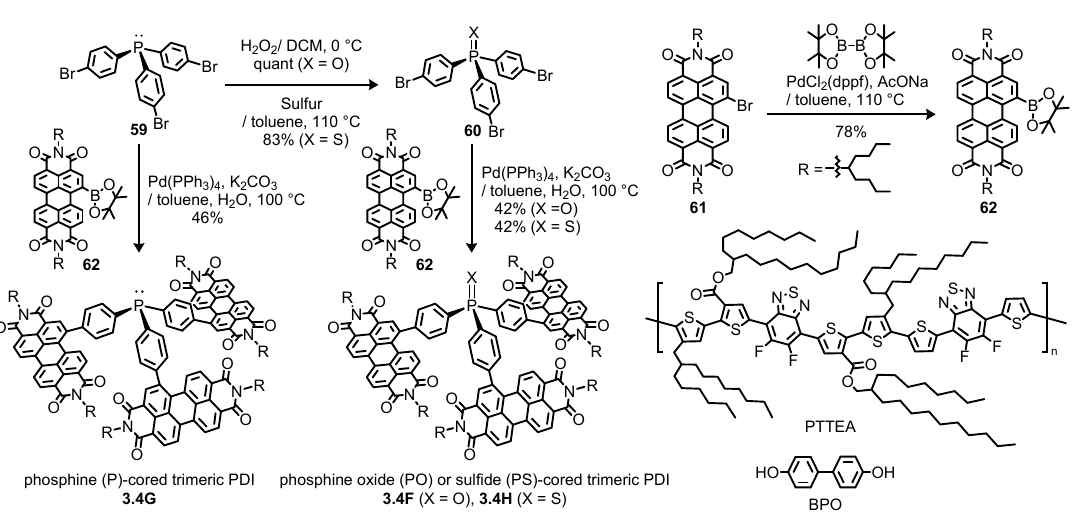
e ff ect. Namely, supramolecular hydrogen bonding networks via O-H ··· F and O-H ··· O = P interactions trigger morphological changes in crystallinity and interpenetrating nanostructures of the BHJ